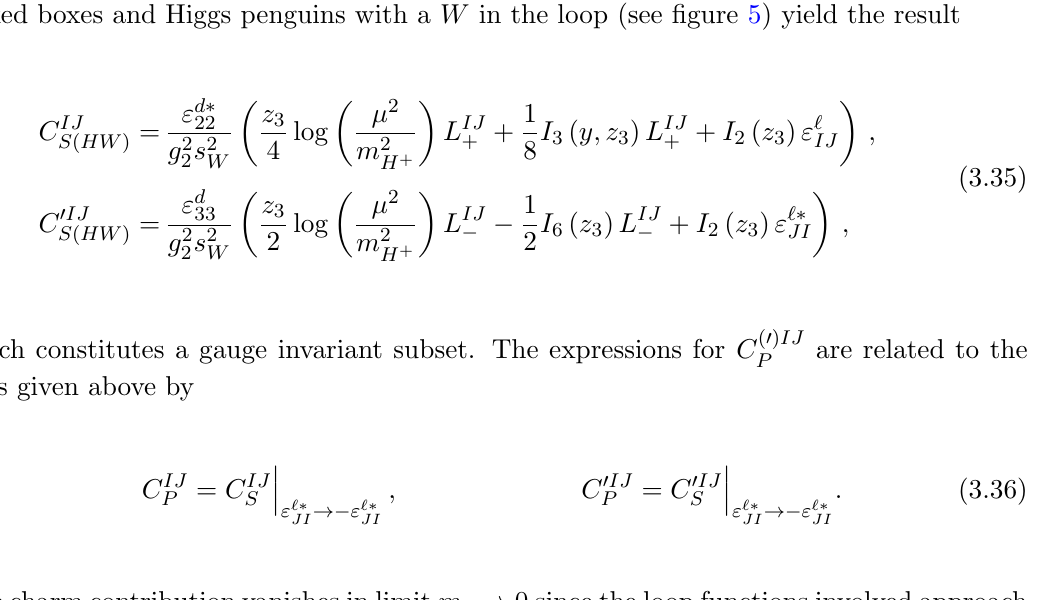
Figure 5 . Mixed H - W box-diagrams and Higgs penguins contributing to C ( 0 ) IJ It is understood for the W diagrams that the Goldstone bosons are implicitly